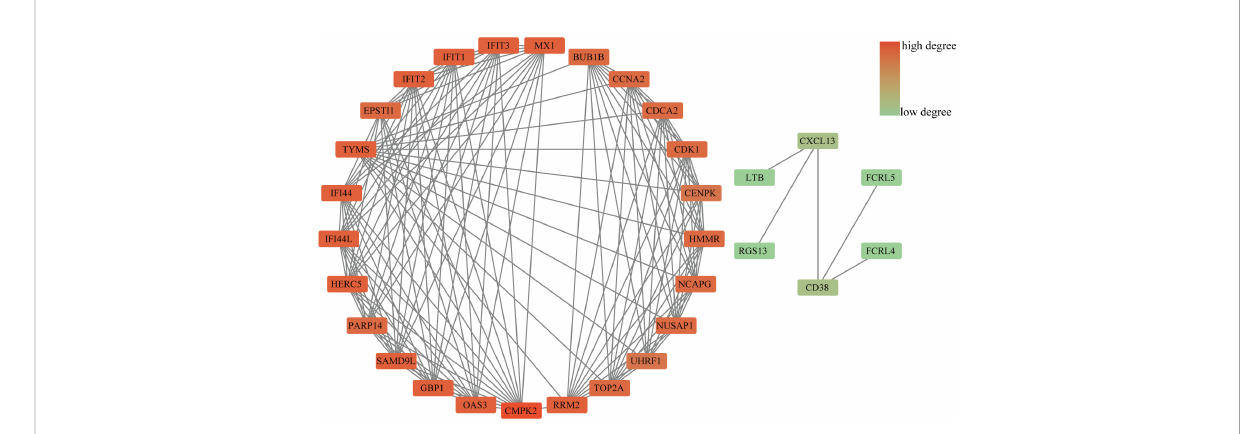
FIGURE 4 PPI network diagram. The redder the color of the gene in the network, the higher the connectivity of the gene with other